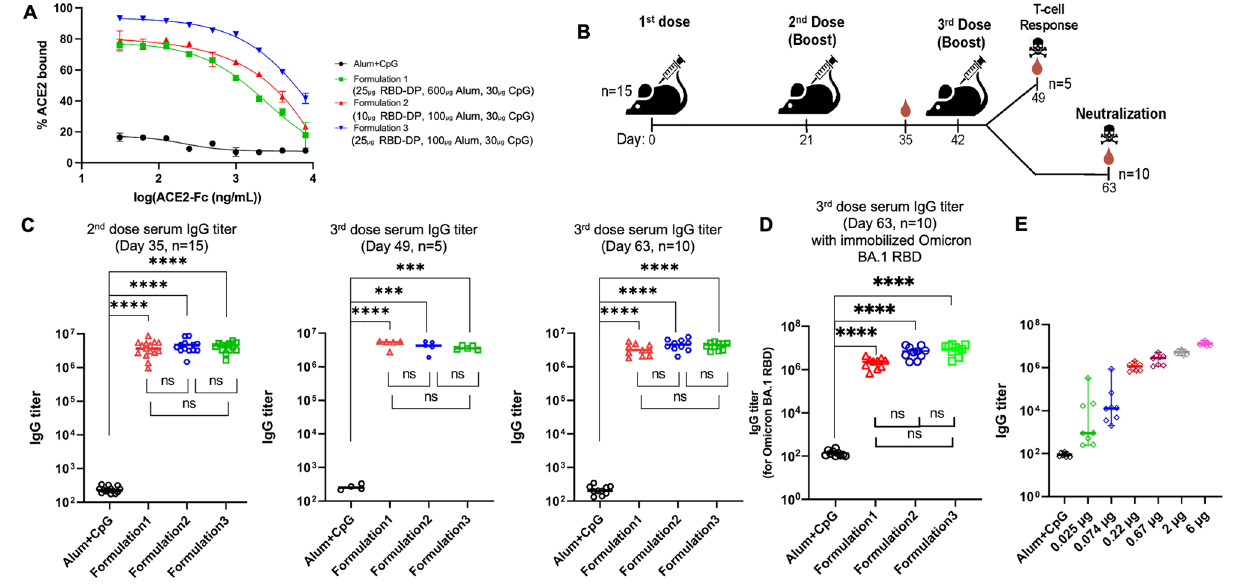
Figure 4. Humoral response induced by the RBD-DP vaccine. ( A ) ELISA-based ACE2 binding assay of RBD-DP in the three formulations used. ( B ) Study design for the animal immunizations. ( C ) Total IgG titers for the three different formulations after the 2nd and 3rd dose at days 35, 49, or 63. ( D ) Total IgG titer for Omicron BA.1 RBD for the serums after the 3rd dose at day 63. In ELISA set-up, instead of RBD-DP, the same amount of produced Omicron BA.1 RBD was immobilized on the plate. ( E ) Dose–response study with different amounts of RBD-DP (0–6 μg) in 100 µg Alum and 30 µg CpG. The total IgG titers reached plateau after 0.22 µg of